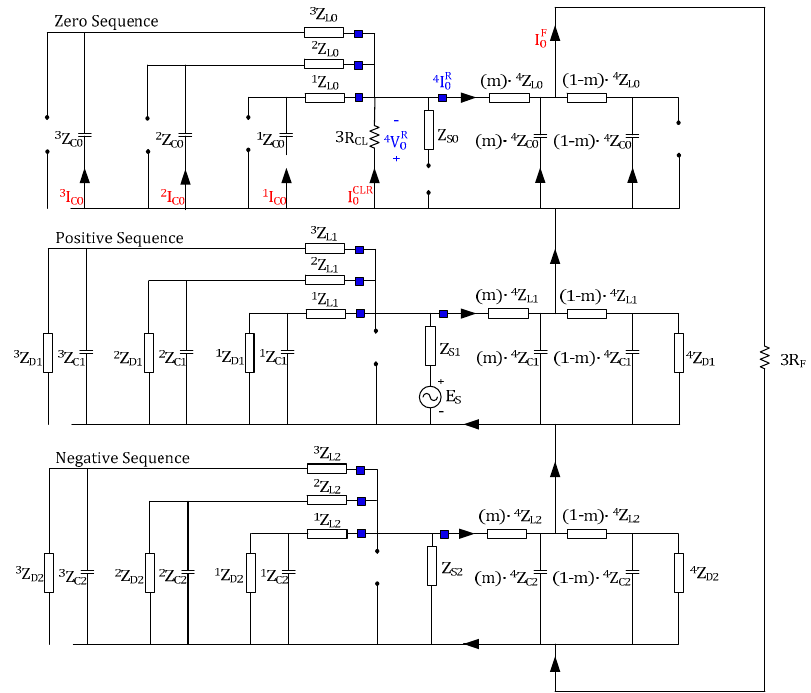
Figure 2. Interconnections of sequence networks in the case of a single line-to-ground (SLG) fault developed in the fourth feeder.